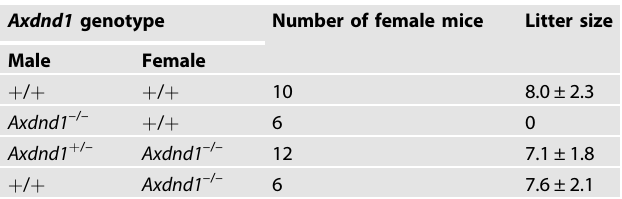
Table 1. The fecundity test of Axdnd1 − / −